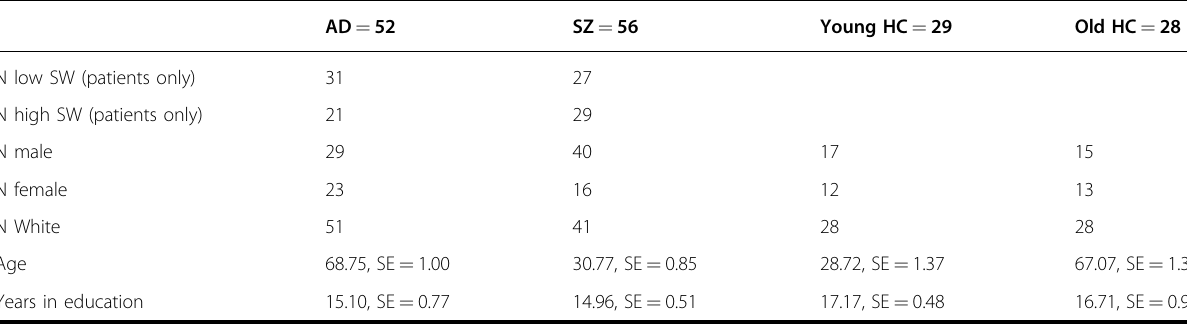
Table 1 Characteristics of the IMI PRISM clinical study